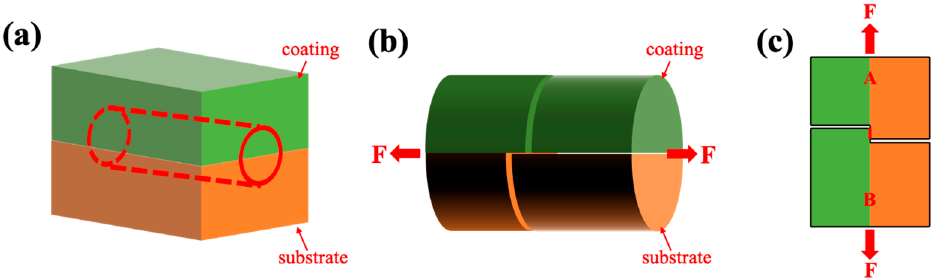
Figure 2. Scheme of shear bonding test, in which the green area represents the Fe/Al coating and the orange area represents the substrate; the bar in ( b ) was cut from ( a ) and the rectangle in ( c ) is the front view of ( b ).